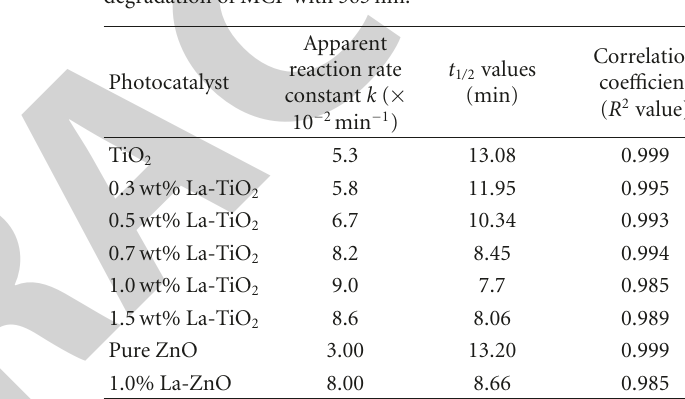
Table 4: Apparent reaction rate constants and t 1 / 2 values for the degradation of MCP with